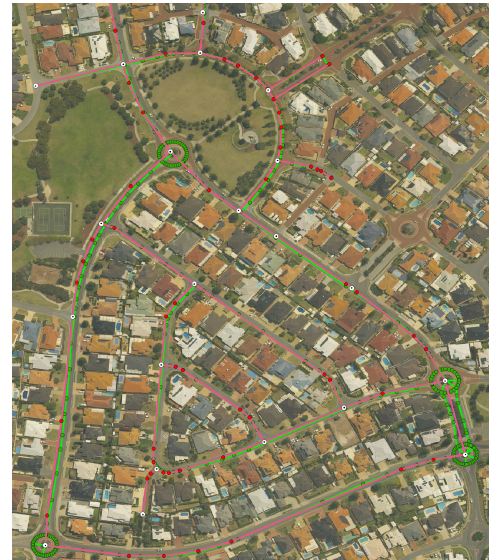
Figure 10. Initial data set representation of the Landgate SLIP and MRWA road networks.